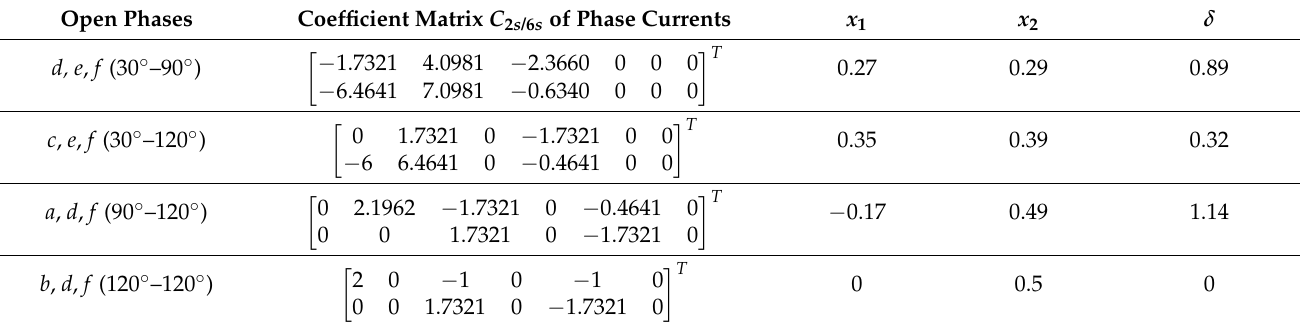
Table 3. Optimum Solutions of Phase Currents and Parameters of Matrix X Under Three-Phase-Open Fault. Open